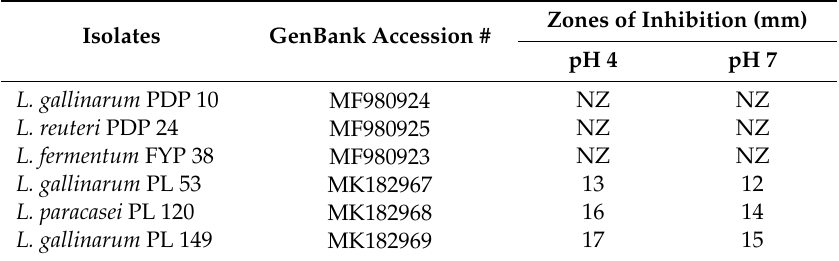
Zones of Inhibition